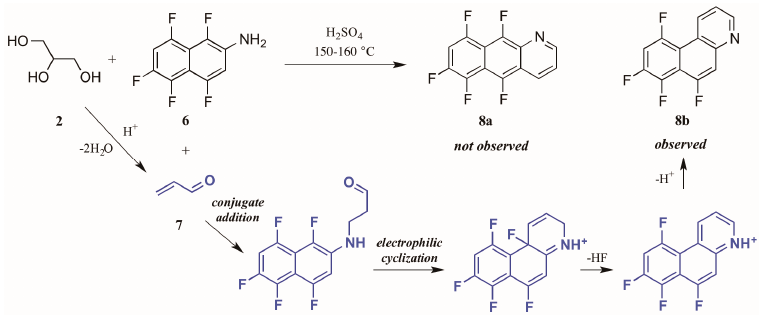
Figure 6. Electrophilic substitution of fluorine in the Skraup reaction.